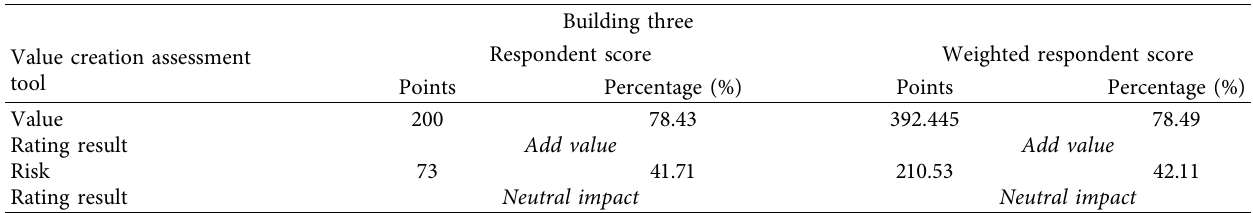
Figure 4: Assessment results for Building 3, (a) value clusters (subcriteria) plots, (b) value groups (value creation drivers) plot, and (c) risk groups plot. Table 10: Building three fnal rating